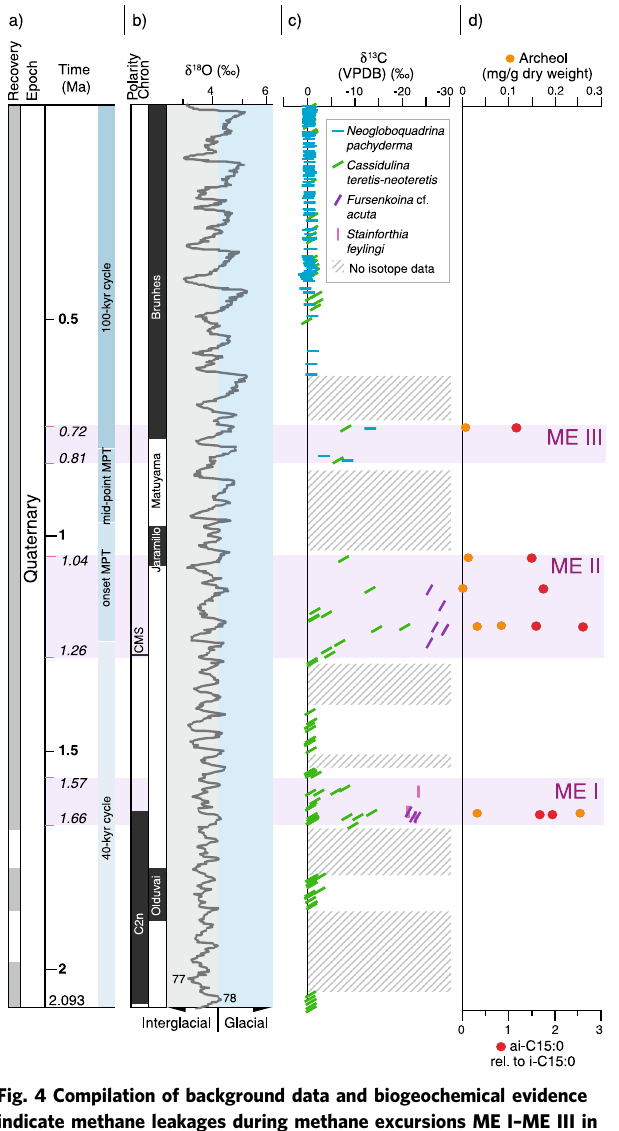
foraminifera expressed in ‰ vs VPDB. Depleted values characterise methane emission events ME I, ME II and ME III. d AOM lipid biomarkers measured within ME I, ME II and ME III show the presence of anaerobic oxidation of methane (AOM)-related biomarkers of archaea (archaeol) and sulfate-reducing bacteria (SRB). The typical AOM consortia indicate the presence of methane oxidation and processes involved in the formation of secondary authigenic carbonate overgrowth in foraminiferal tests. See Supplementary Table 3 for the complete dataset of δ 13 C values measured in planktonic and benthic foraminifera and Supplementary Table 4 for the biomarker